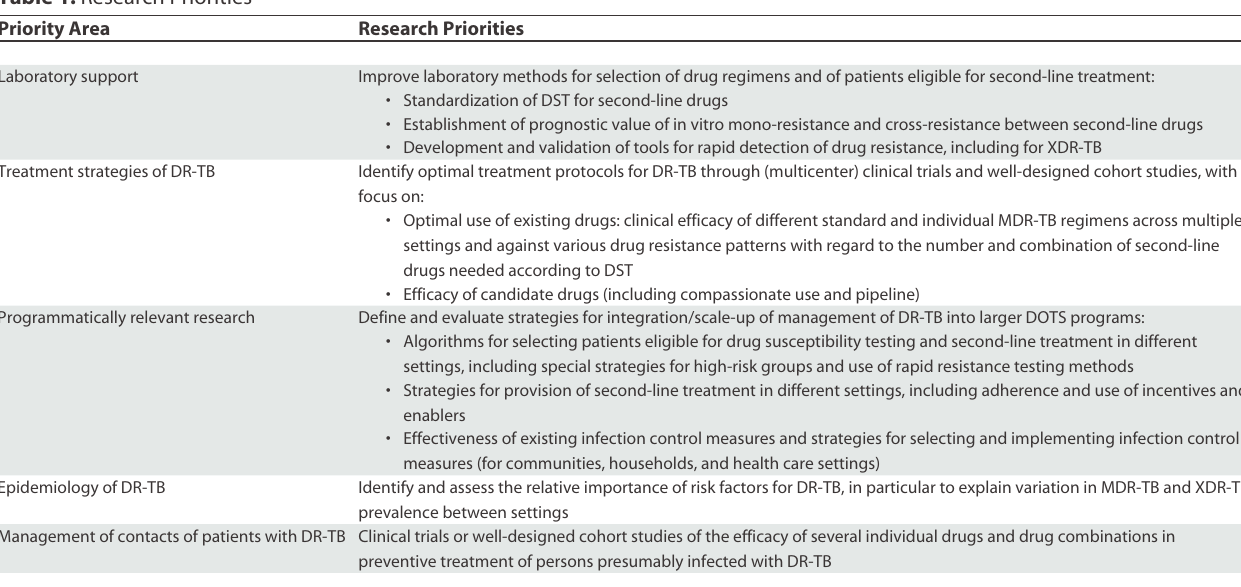
Table 1. Research